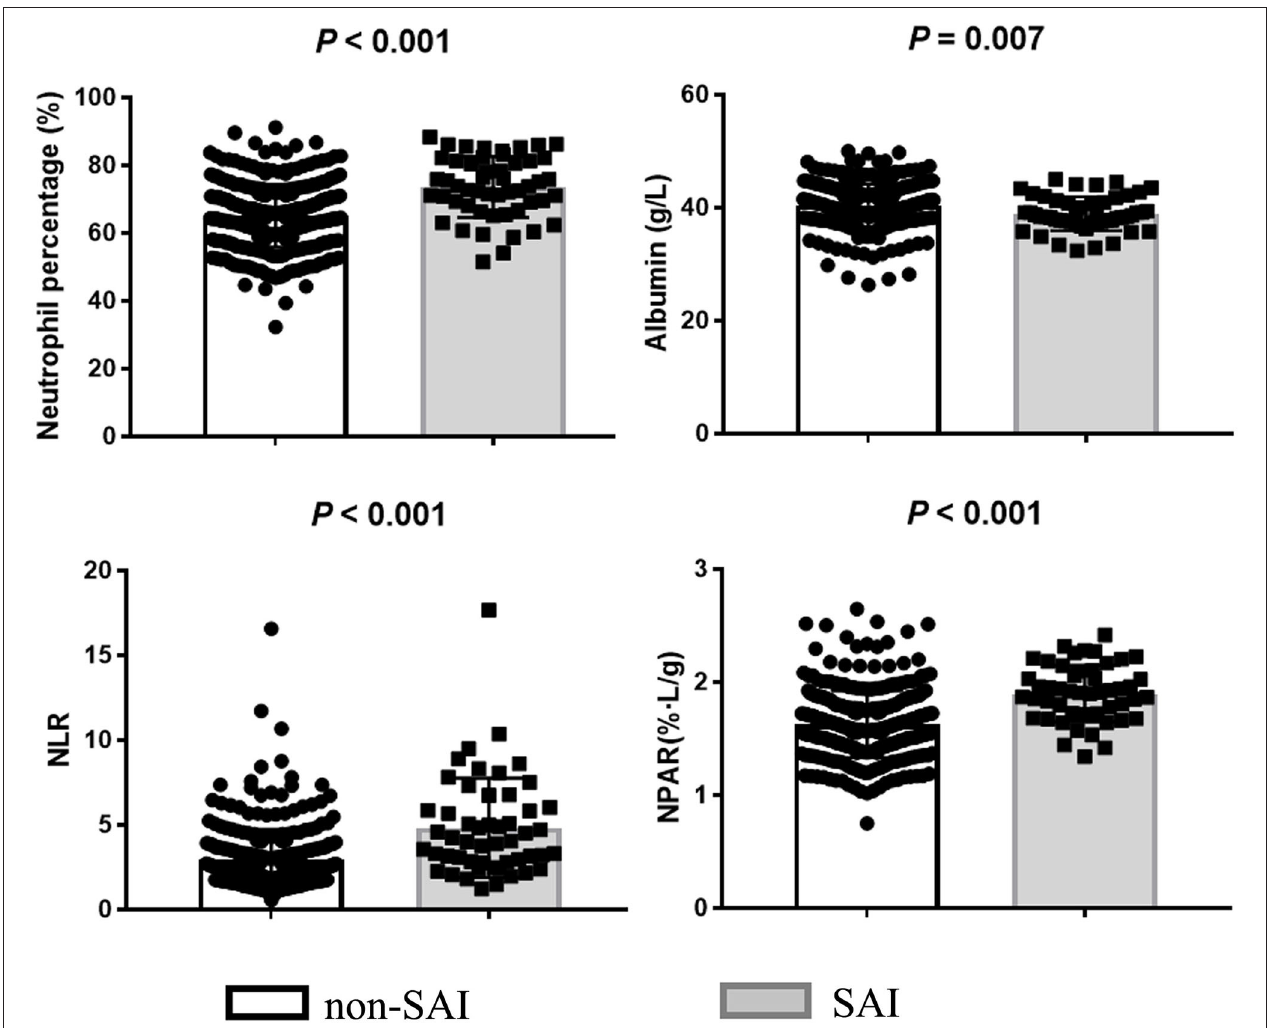
FIGURE 1 | Biomarker levels of neutrophil percentage, albumin, NLR, and NPAR in SAI and non-SAI group.